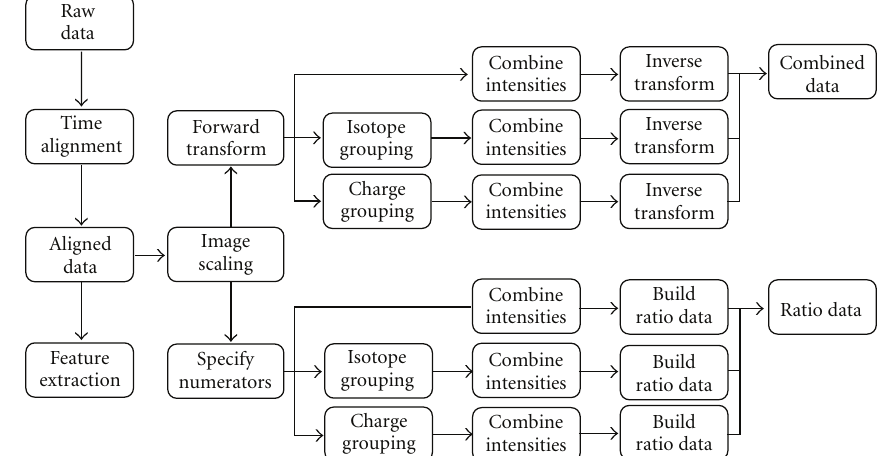
Figure 5: Diagram describing the general data processing steps Rosetta Elucidator use to calculate di ff erent data types out of raw, spectral input from a mass spectrometer (from Rosetta Inpharmatics LLC, Seattle, Wash, USA).